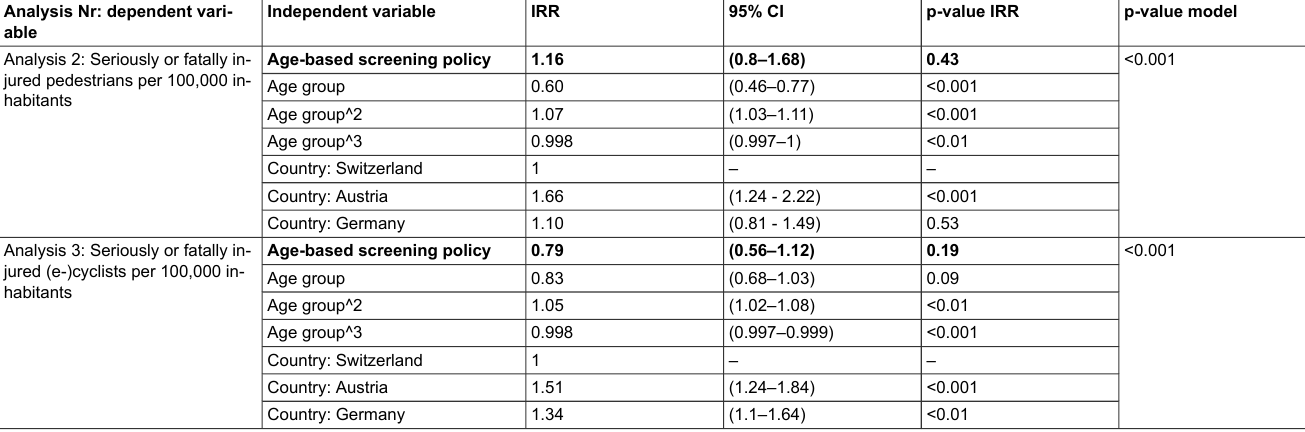
Table 4: Results of the Poisson regression analyses relating to research question 2: IRRs for the independent variables with corresponding 95% confidence intervals and p-values. The variable of interest is written in bold. Analysis Nr: dependent vari-